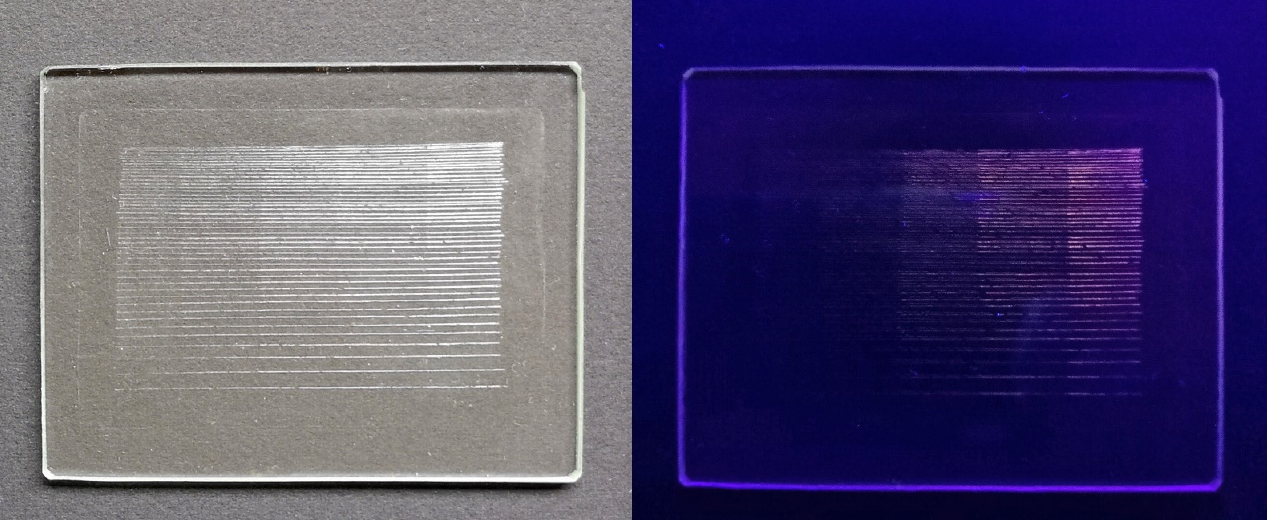
Figure 4. Screen-printed sodalite zeolite composite film depositions on glass. Sample viewed with visible light ( left ), sample viewed with UV light ( right ). Author’s photos. Figure created by author.